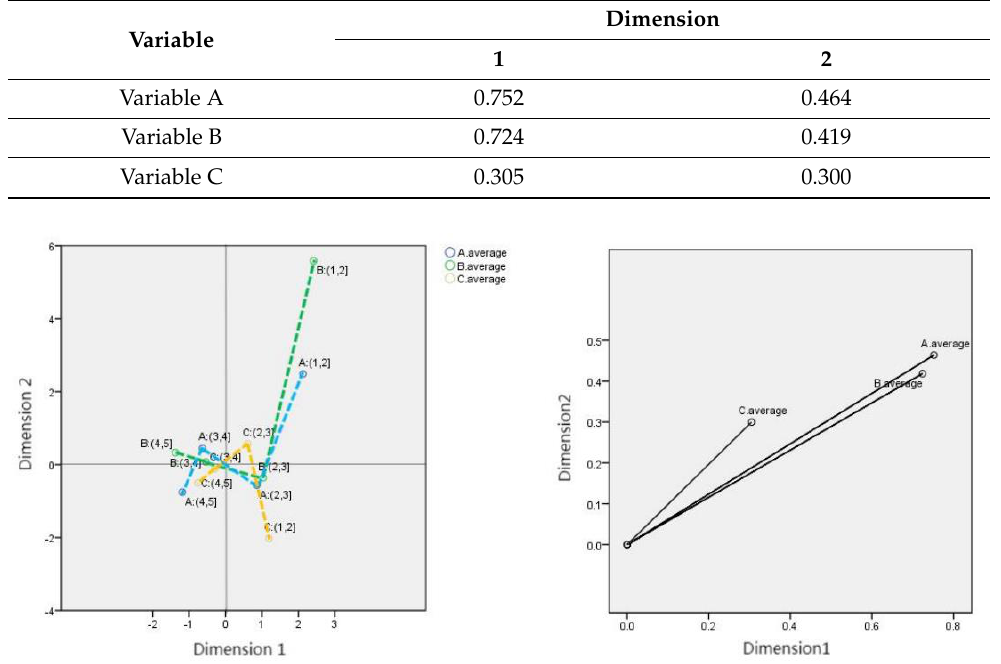
Table 7. Discrimination measures of the three variables.